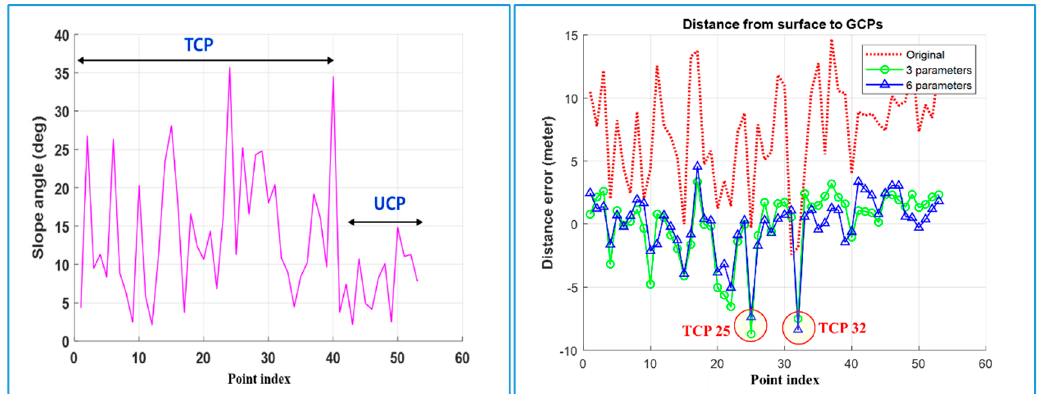
Figure 10. Slope angles at the surface points (left) and distances between GCPs and DEM before and after matching (right).